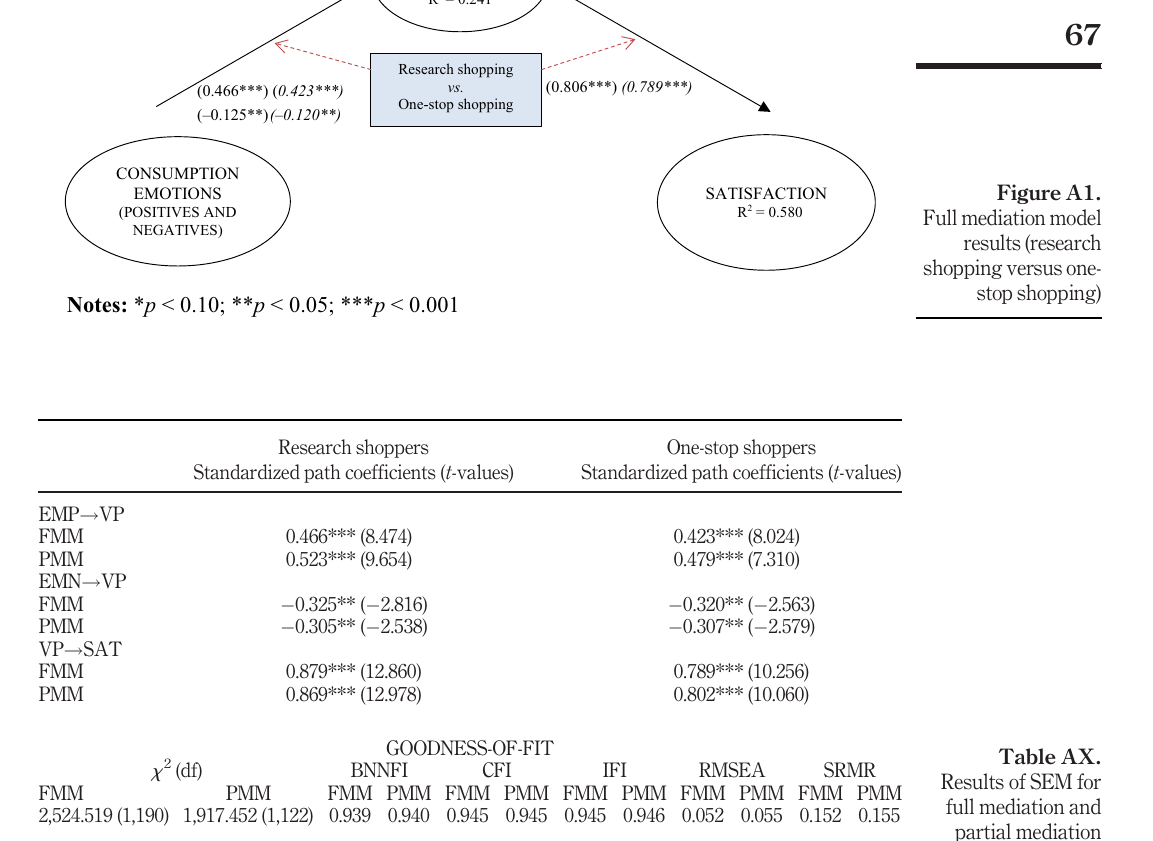
Table AX. Results of SEM